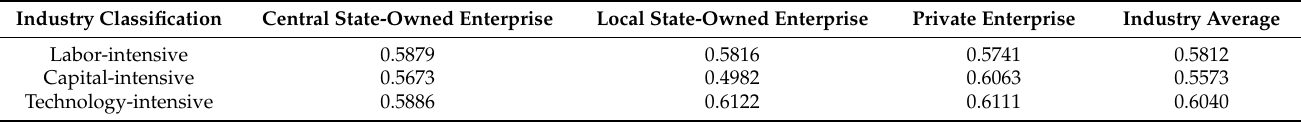
Table 4. The average value of TE of enterprises under all kinds of ownership by